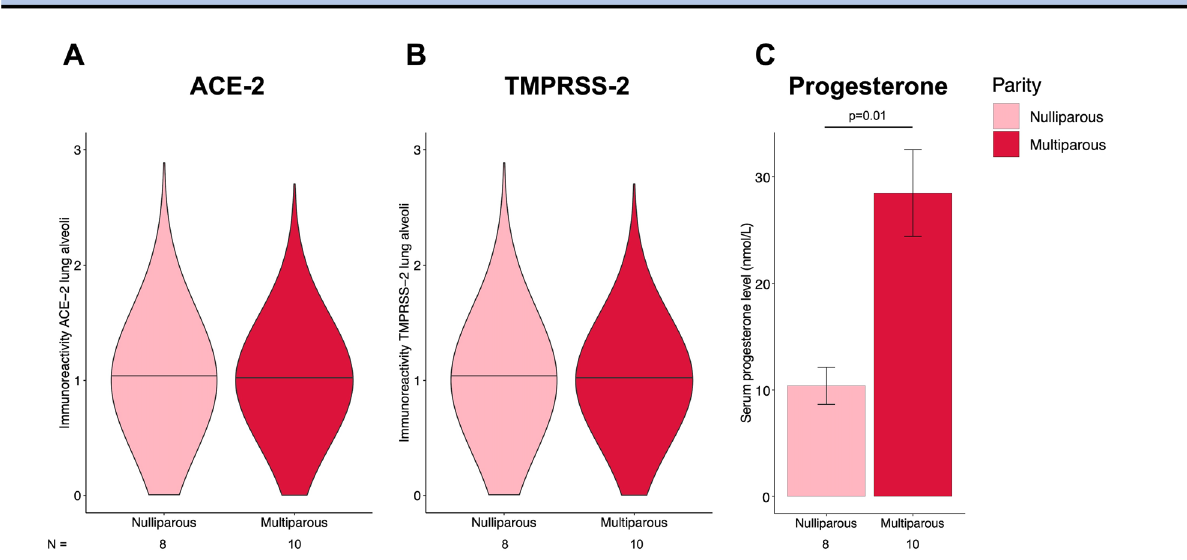
Figure 4. ACE-2 and TMPRSS-2 immunoreactivity in lung alveoli in murine models of pregnancy. The violin plots ( A and B ) provide information on the full data distribution. The horizontal black line indicates the median of the kernel density plot. ( A ) ACE-2 immunoreactivity in lung alveoli of 12 months-old multiparous and nulliparous mice. ( B ) TMPRSS-2 immunoreactivity in lung alveoli of 12 months-old multiparous and nulliparous mice. ( C ) Serum progesterone level in both groups. Mann–Whitney test was performed to compare the median of the tissue expression of ACE-2 and TMPRSS-2 between nulliparous and multiparous. Unpaired Student’s t-test was applied for comparison of progesterone levels. Only significant p-values are reported (more details in Table 3). ACE-2, angiotensin-converting enzyme 2; TMPRSS-2, transmembrane protease serine